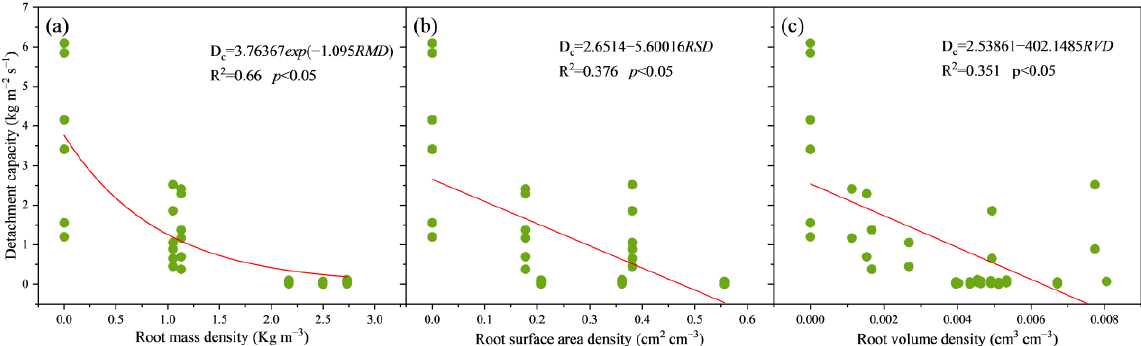
Figure 7. Relationship between root system and soil detachment capacity. Notes: ( a ) root length density; ( b ) root surface area density; ( c ) root mass density.